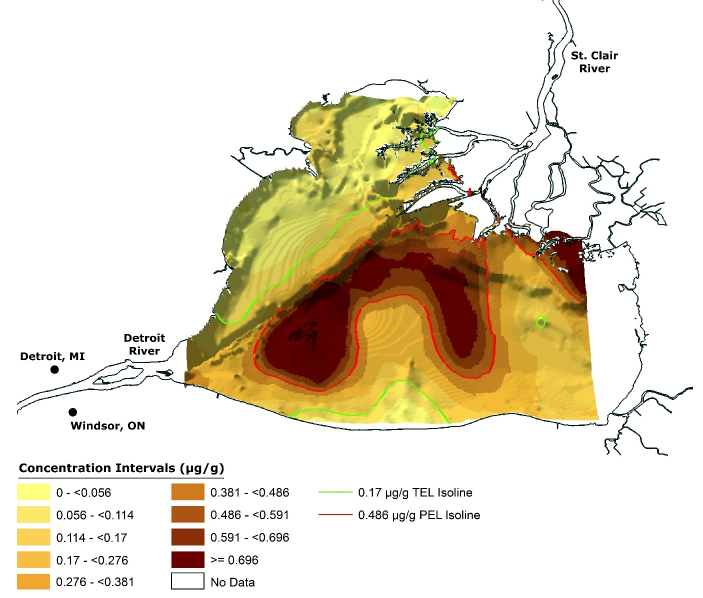
Figure 4. Three ‐ dimensional interpolated kriging distribution map for 1970.